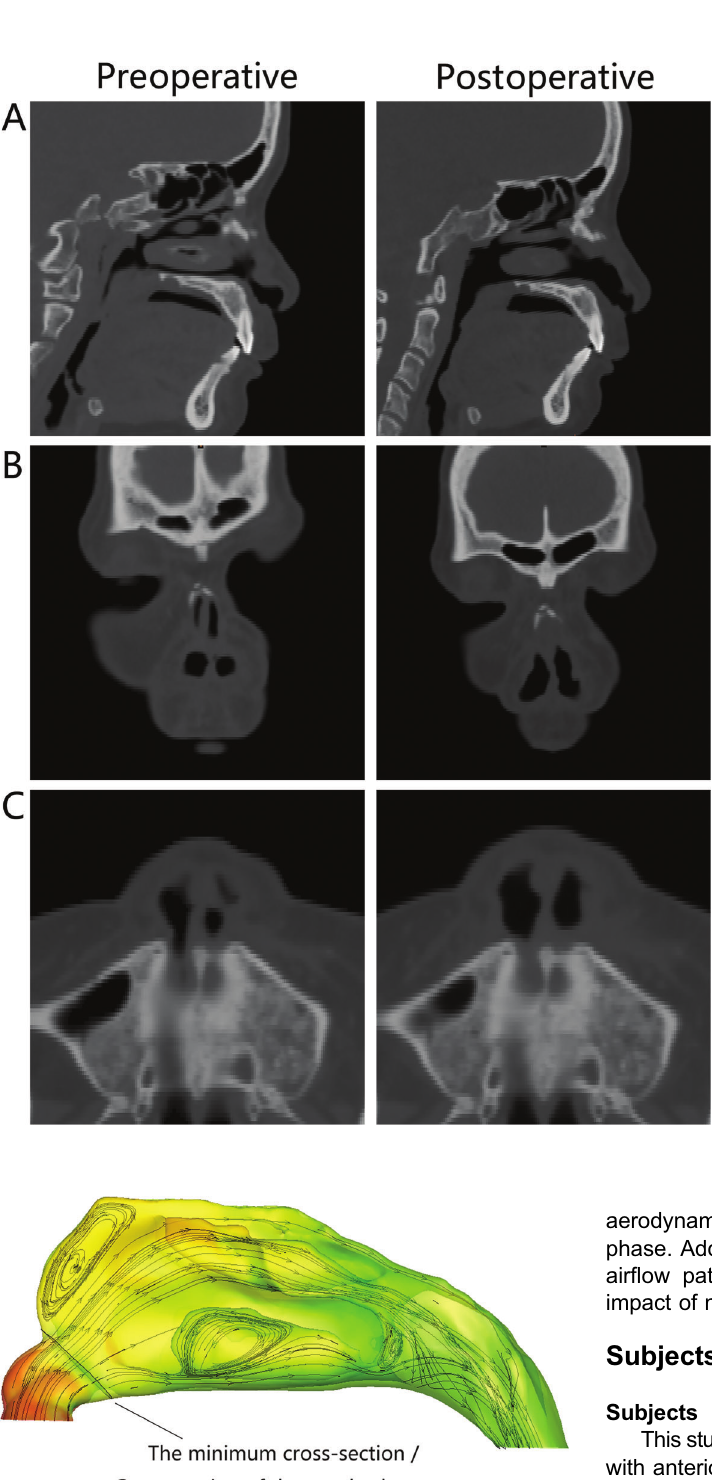
Figure 1. Pre- and postoperative anterior nasal cavity stenosis. A , sagittal and B , coronal com- puted tomography of the nasal cavity. C , Nasal base view.